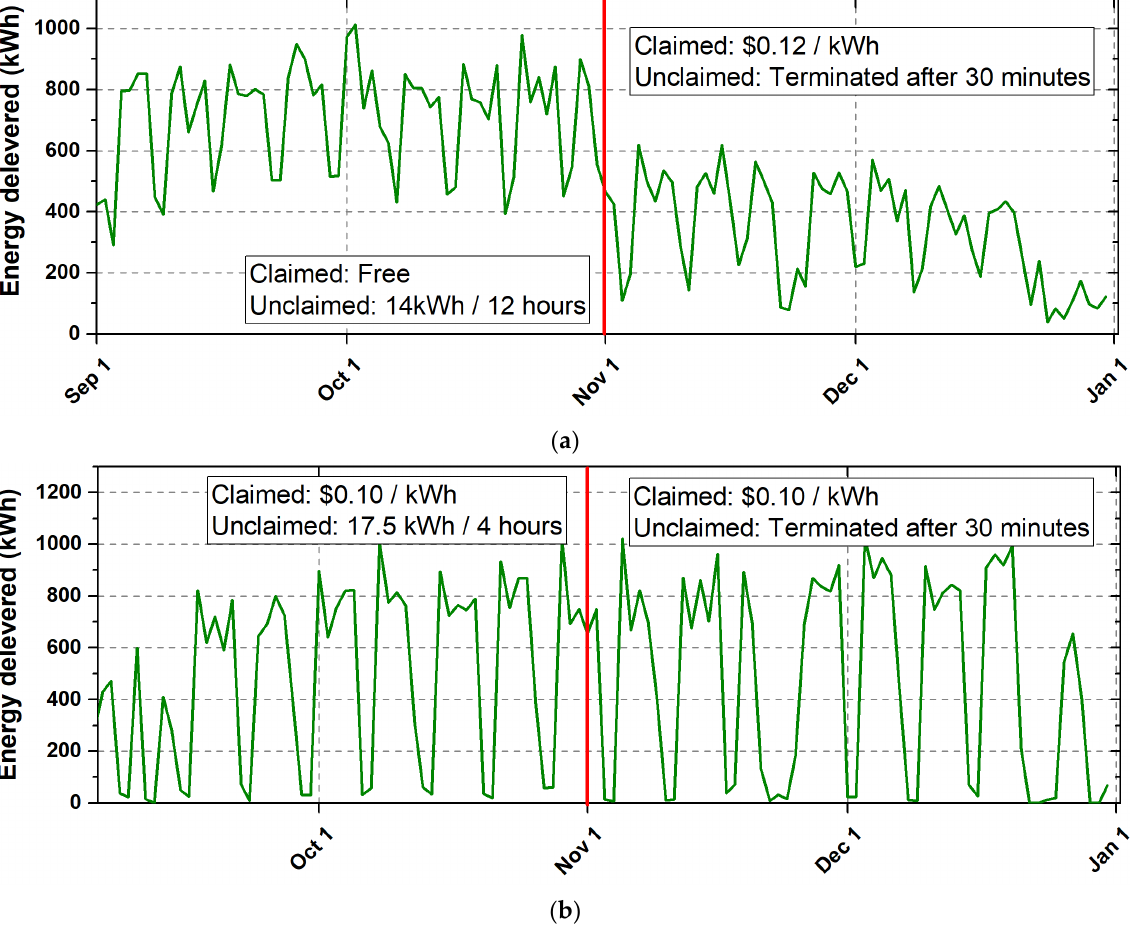
Figure 6. Policy change vs. power demand. ( a ) Caltech. ( b ) JPL.